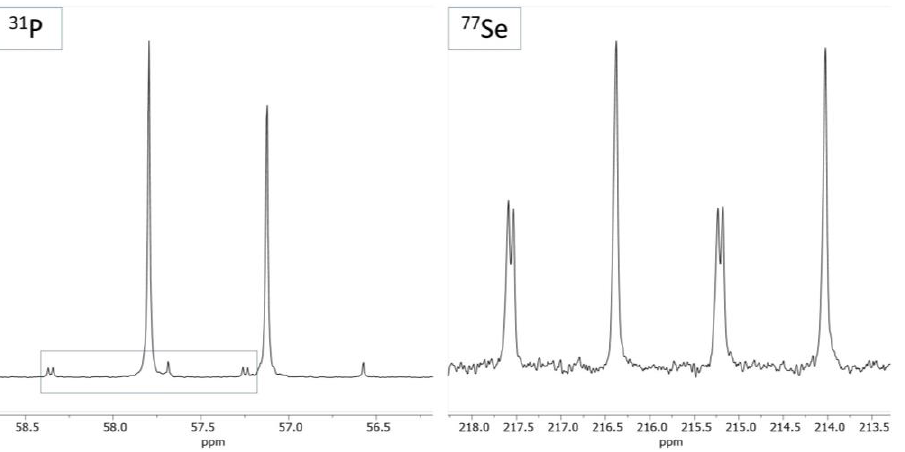
Figure 3. 31 P-NMR spectrum (left) and 77 Se-NMR spectrum (right) of 3b (C 6 D 6 , 300 K).